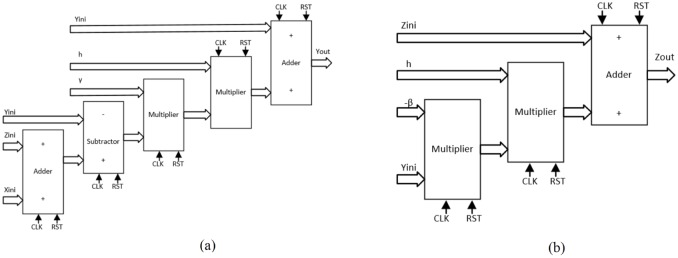
Hardware connection for implementing.(a) y[k + 1] and (b) z[k + 1] from Eqs (11) and (12).